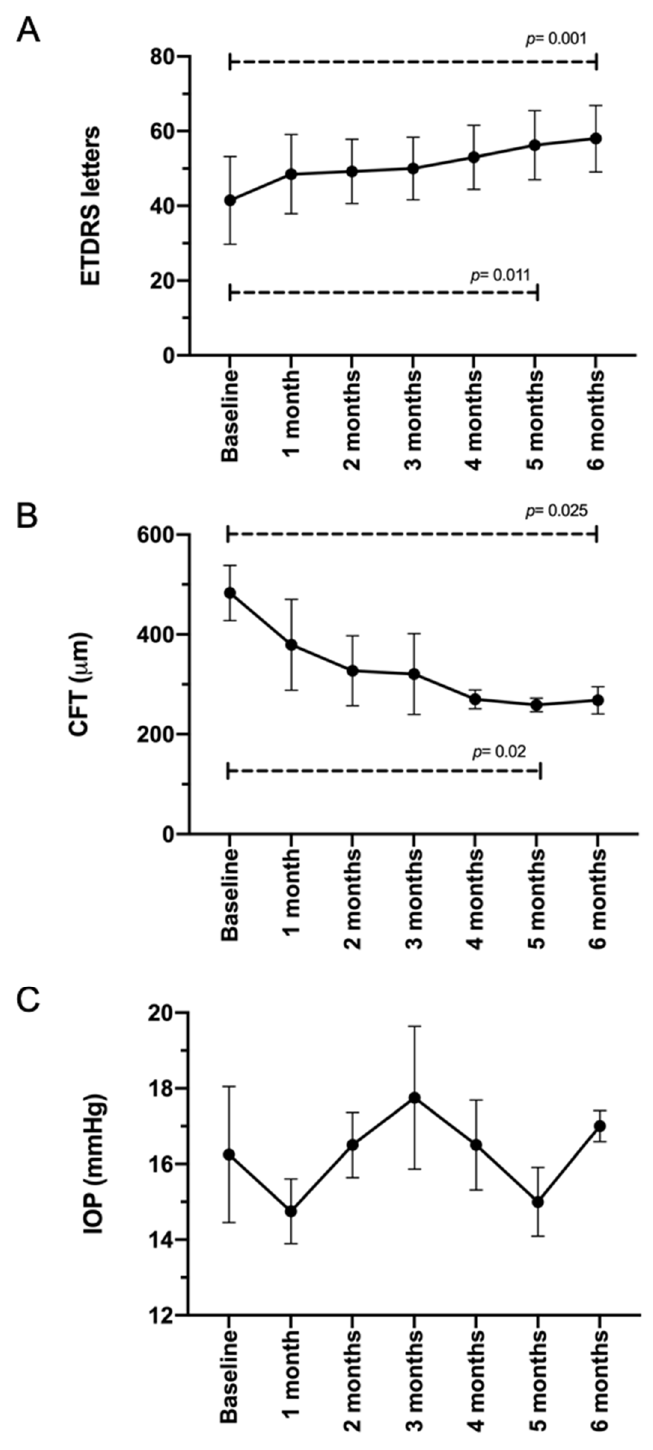
Figure 4. Best corrected visual acuity, central foveal thickness, and intraocular pressure follow-up in patients with diabetic macular edema treated with triamcinolone acetonide-loaded liposomes formulation. ( A ) Best corrected visual acuity, measured by ETDRS test, improved through the follow-up, reaching statistical significance at month 5. ( B ) CFT, measured by OCT, contracted through the follow-up, accomplishing statistical significance at month 4. ( C ) Non-significant variation in IOP was recorded during the study. ETDRS; Early Treatment Diabetic Retinopathy Study, CFT; central foveal thickness, OCT; optical coherence tomography.